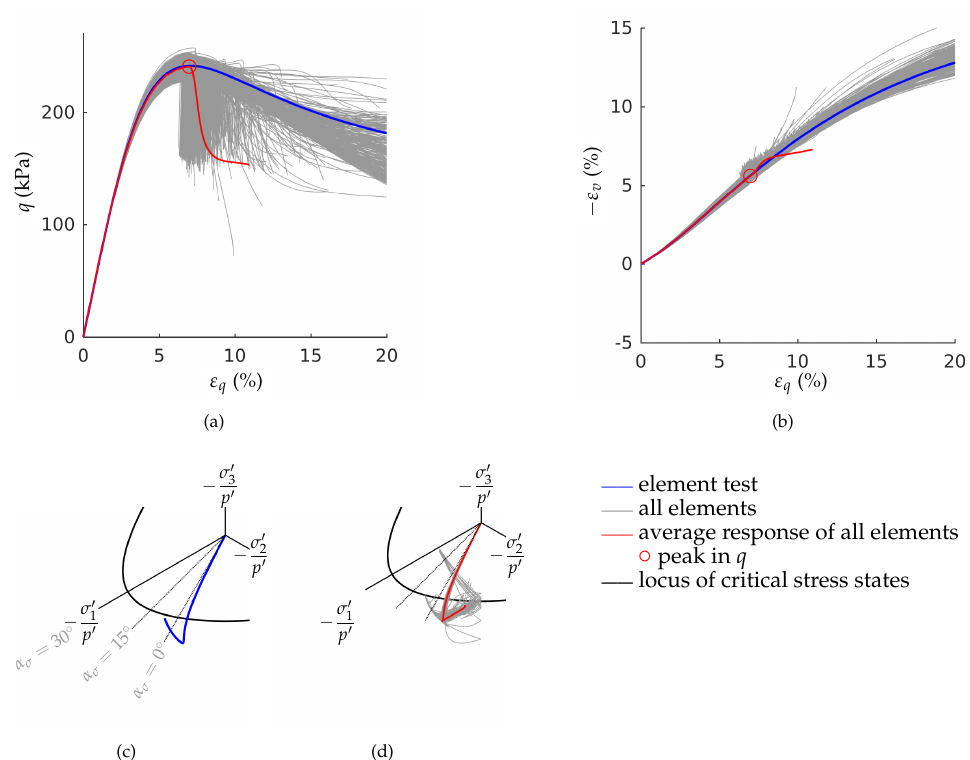
Figure 17. OCR = 54: ( a ) Deviatoric strain ε q -deviatoric stress q plot; ( b ) Deviatoric strain ε q -volumetric strain ε v plot; ( c , d ) Stress paths for OCR = 1.5 in the deviatoric plane normalized with the mean effective stress p (cid:48)